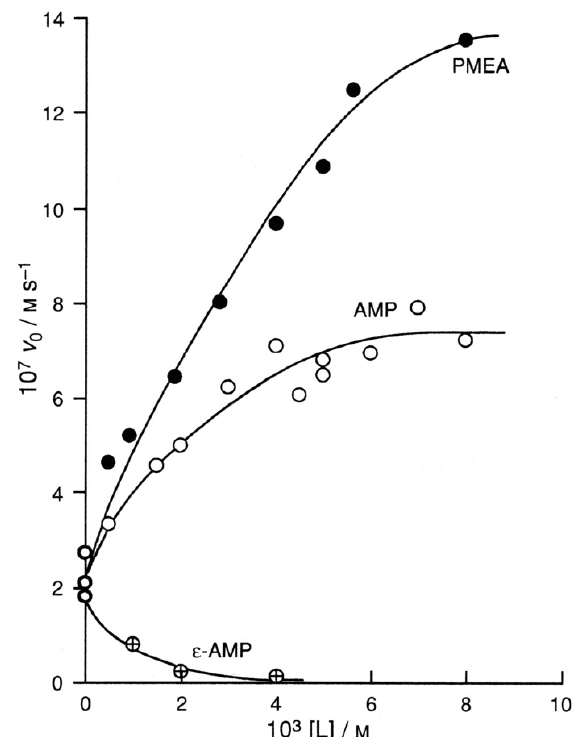
Figure 11. Influence of AMP ( ◯ ) and PMEA ( ) as well as of ε -AMP (Figure 12) on the initial rate v 0 (M s − 1 ) of the dephosphorylation of the Cu 2+ /ATP 2:1 system ([Cu 2+ ] tot = 2 × 10 − 3 M and [ATP] tot = 10 − 3 M) in aqueous solution at pH 6.70 ( I = 0.1 M, NaClO 4 ; 50 °C). This figure is adapted with permission from Figure 3 of our publication in Chem. Commun. [94]; copyright 1998, The Royal Society of Chemistry.